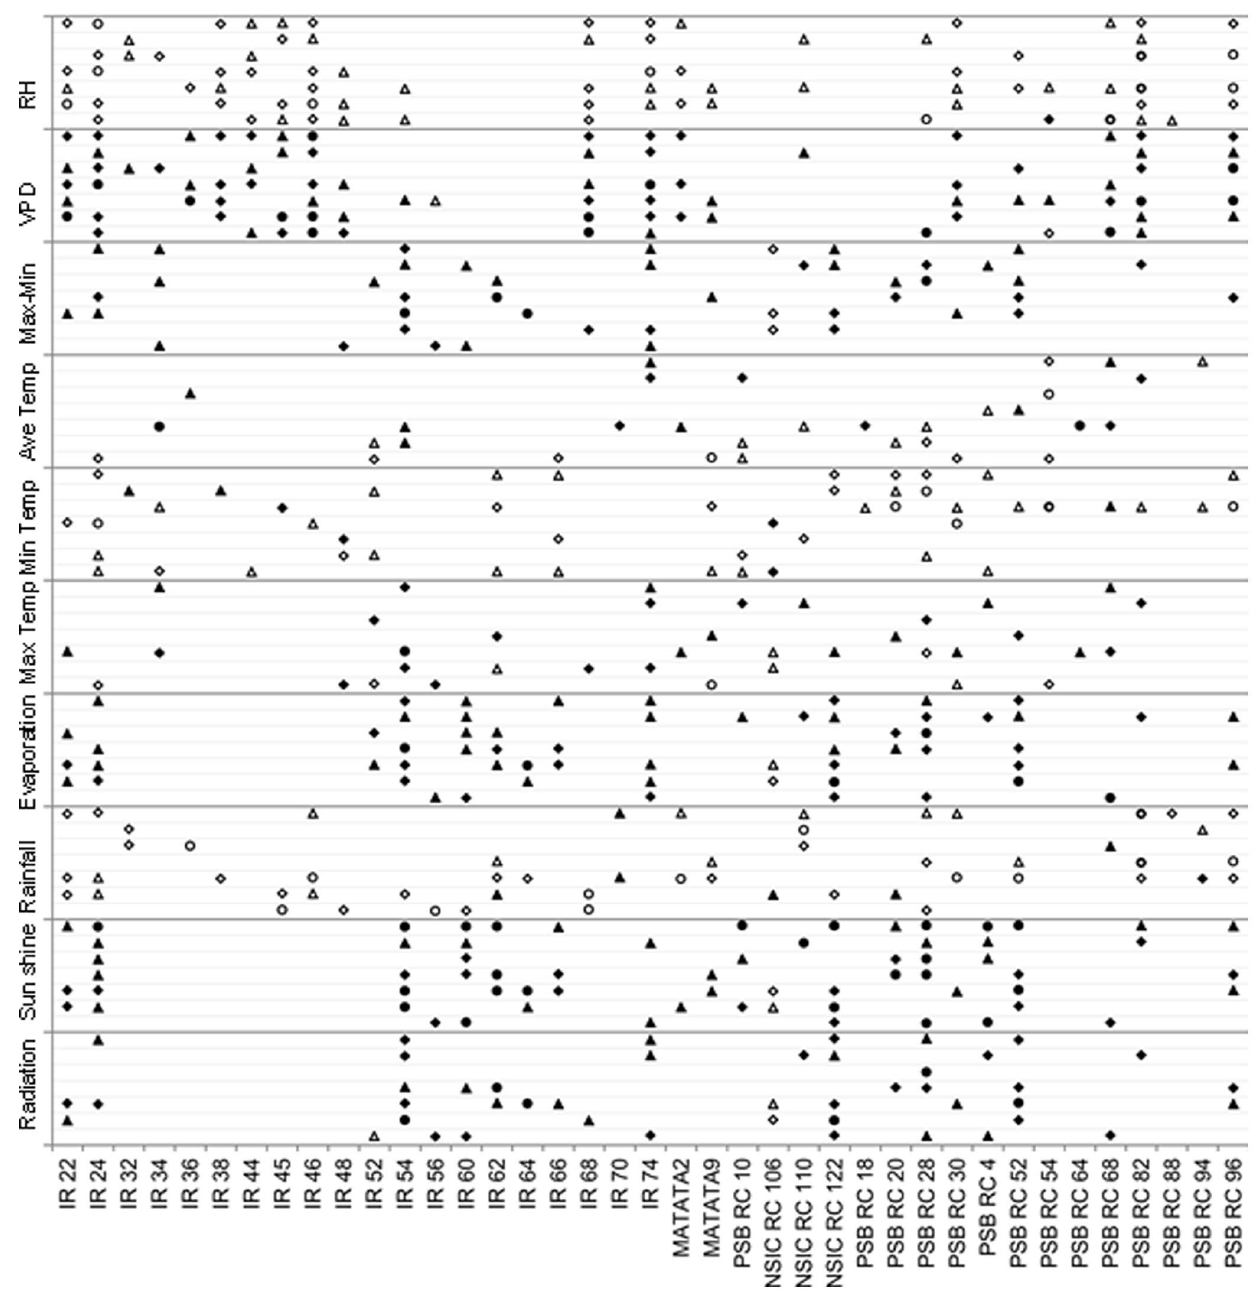
Figure 2. Association between HRY and weather parameters for each variety across 8 seasons. Triangles, diamonds and circles represent significance at P , 0.10, P , 0.05 and P , 0.01 respectively. Blank and solid shapes represent negative and positive associations respectively. Gray lines from below to upper for each weather parameter represent 0–5, 6–10, 11–15, 16–20, 21–25, 26–30 and the whole grain filling stage.